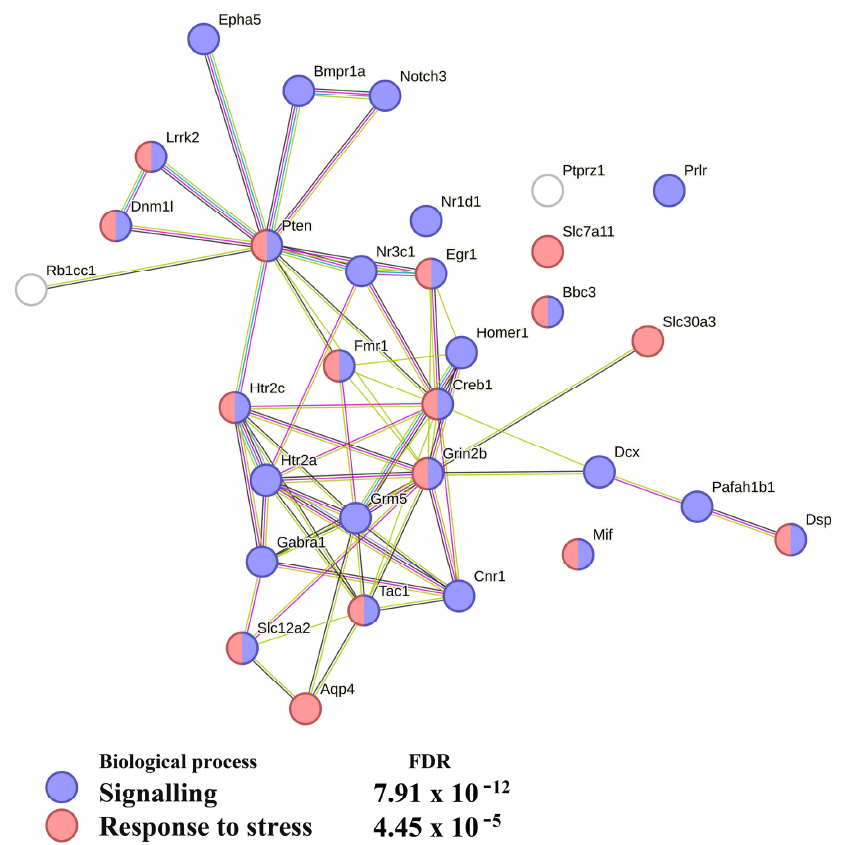
Figure 5. Functional enrichment analysis of the neurogenesis network constructed for the C_AD comparison. This analysis suggests that the DEGs in question may contribute to the signaling and response to stress. The functional enrichment network was constructed by means of the STRING database (https://string-db.org/; accessed on 7 November 2022) using the DEGs associated with neurogenesis. Each node represents all the proteins produced by a single protein-coding gene. Edges are protein–protein associations. Purple lines indicate experimentally determined interactions; blue lines denote known interactions from curated databases; dark blue lines represent gene co-occurrence; black lines indicate coexpression; and green lines represent results of text mining. Protein–protein interaction (PPI) enrichment p -value < 1.0 × 10 − 16 . FDR: false discovery rate.